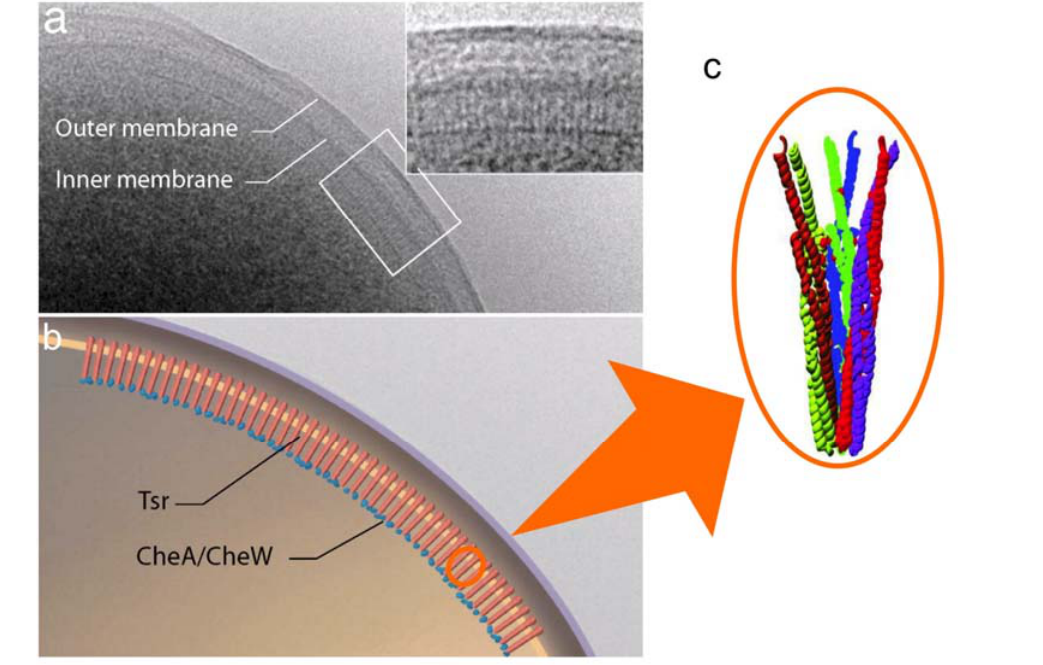
Figure 9. Visualization and identification of chemoreceptor arrays. (a) Low-dose cryo-projection image of the polar region in a wild-type E. coli cell, with the chemoreceptor array shown in greater detail in the Inset . (b) Schematic representation of the polar region of a wild-type E. coli cell illustrating the assembly and orientation of the chemotaxis receptor array, based on a and b. (c) The trimer of dimers of the cytoplasmic fragment of Tsr as a crystal unit. Adopted from reference [162] and